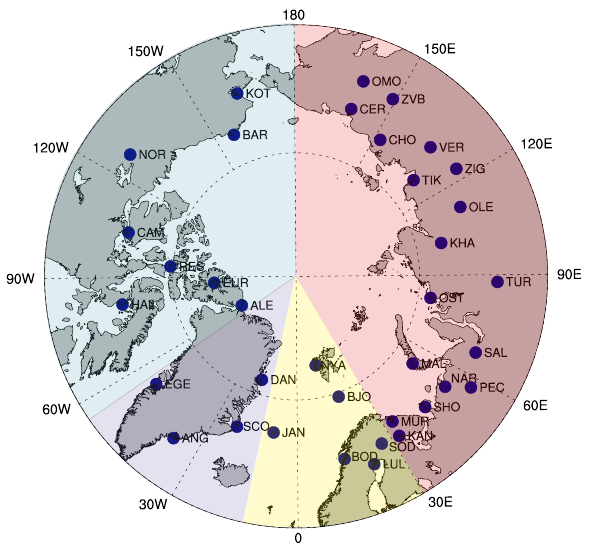
Fig. 1. Locations of the radio-sounding stations in the Arctic. The full station names are given in Table 1. The shaded areas indicate the geographical sectors used in this study.